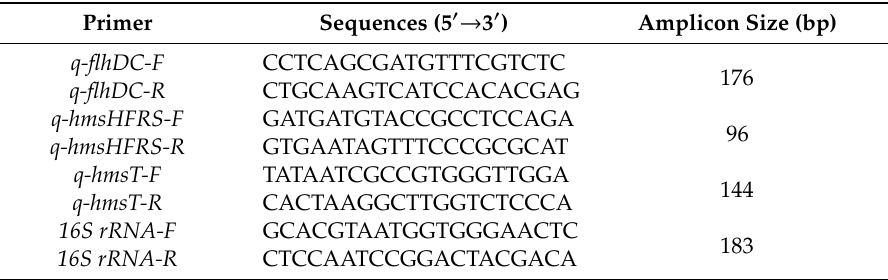
Table 3. Primers used in the RT-qPCR